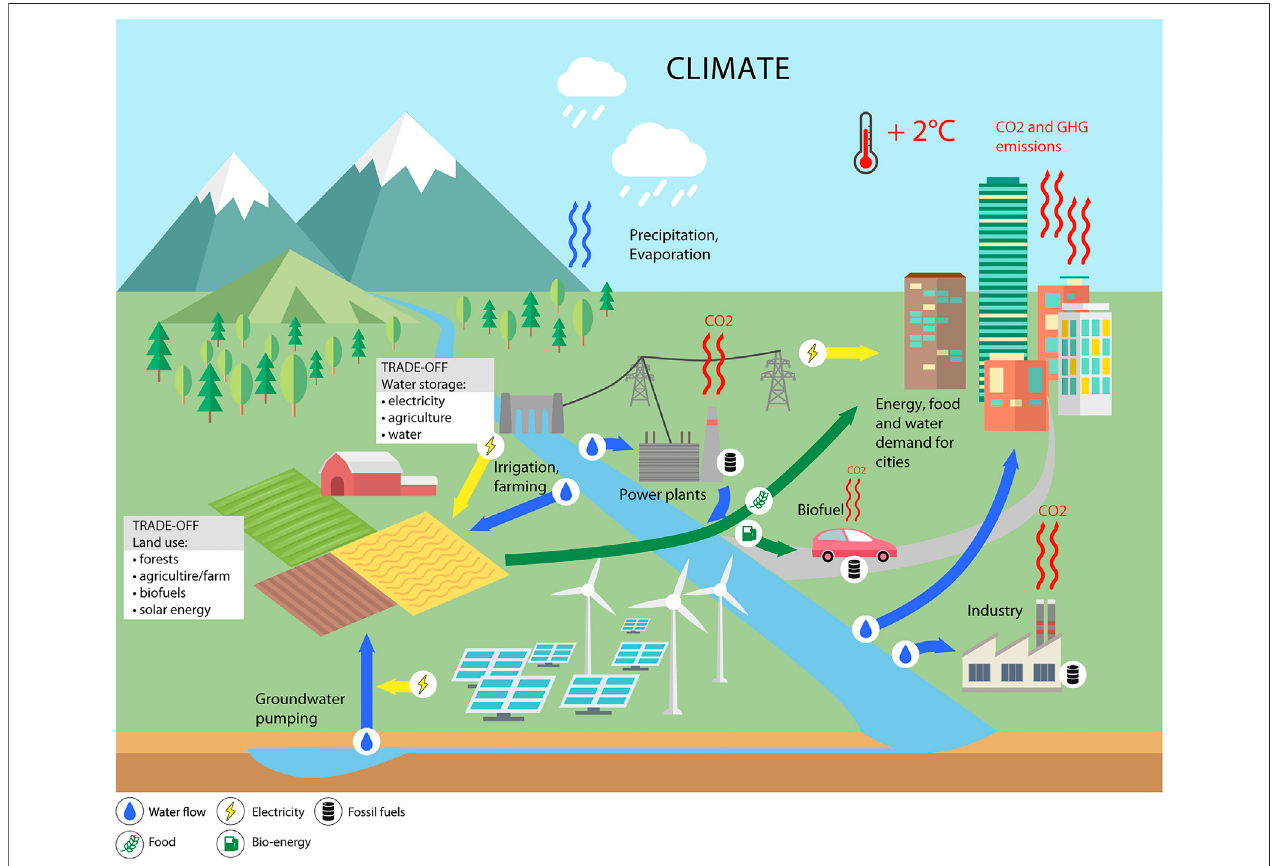
FIGURE1| Schematicofthemaininterconnections betweenclimatelandenergyandwatersystems.ThiscoverhasbeendesignedusingresourcesfromFreepik. com, design from Nucleartist.